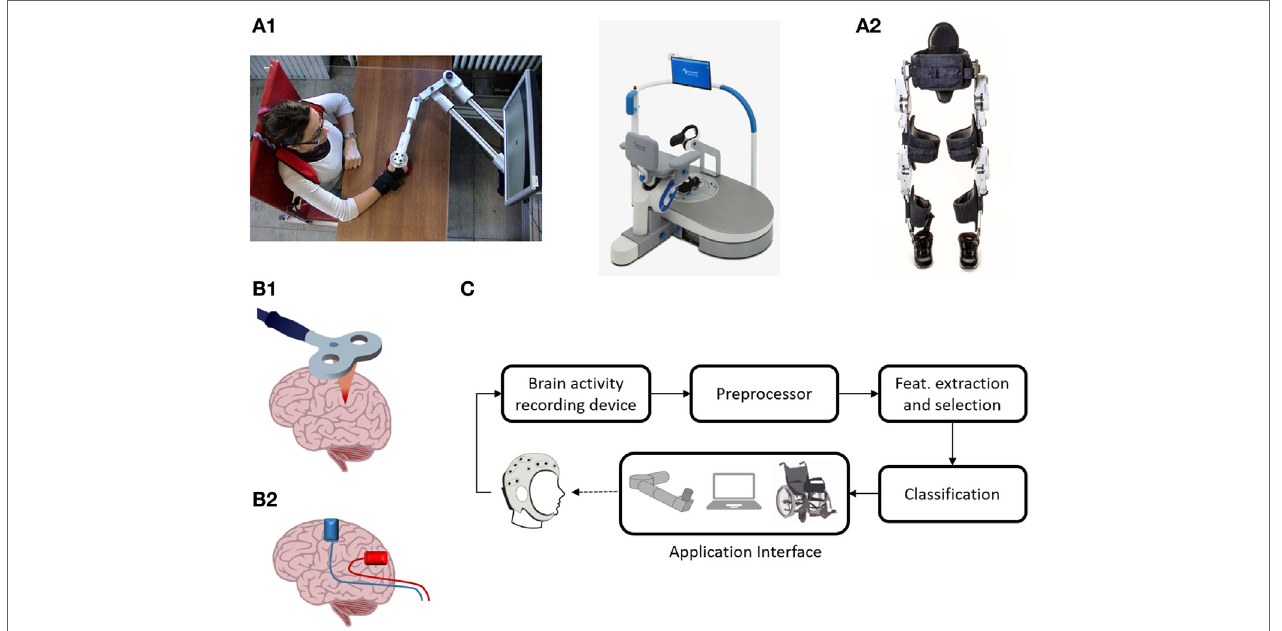
FigUre 1 | Neurorehabilitation therapies. (A1) Endpoint robots: on the left the “Braccio di Ferro” manipulandum, on the right the postural robot Hunova. Braccio di ferro (14) is a planar manipulandum with 2-DOF, developed at the University of Genoa (Italy). It is equipped with direct-drive brushless motors and is specially designed to minimize endpoint inertia. It uses the H3DAPI programming environment, which allows to share exercise protocol with other devices. Written informed consent was obtained from the subject depicted in the panel. Movendo Technology’s Hunova is a robotic device that permits full-body rehabilitation. It has two 2-DOF actuated and sensorized platforms located under the seat and on the floor level that allow it to rehabilitate several body districts, including lower limb (thanks to the floor-level platform), the core, and the back, using the platform located underneath the seat. Different patient categories (orthopedic, neurological, and geriatric) can be treated, and interact with the machine through a GUI based on serious games. (A2) Wearable device: the recent exoskeleton Twin. Twin is a fully modular device developed at IIT and co-funded by INAIL (the Italian National Institute for Insurance against Accidents at Work). The device can be easily assembled/ disassembled by the patient/therapist. It provides total assistance to patients in the 5–95th percentile range with a weight up to 110 kg. Its modularity is implemented by eight quick release connectors, each located at both mechanical ends of each motor, that allow mechanical and electrical connection with the rest of the structure. It can implement three different walking patterns that can be fully customized according to the patient’s needs via a GUI on mobile device, thus enabling personalization of the therapy. Steps can be triggered via an IMU-based machine state controller. (B1) Repetitive transcranial magnetic stimulation (rTMS) representation. rTMS refers to the application of magnetic pulses in a repetitive mode. Conventional rTMS applied at low frequency (0.2–1 Hz) results in plastic inhibition of cortical excitability, whereas when it is applied at high frequency ( ≥ 5Hz), it leads to excitation (19). rTMS can also be applied in a “patterned